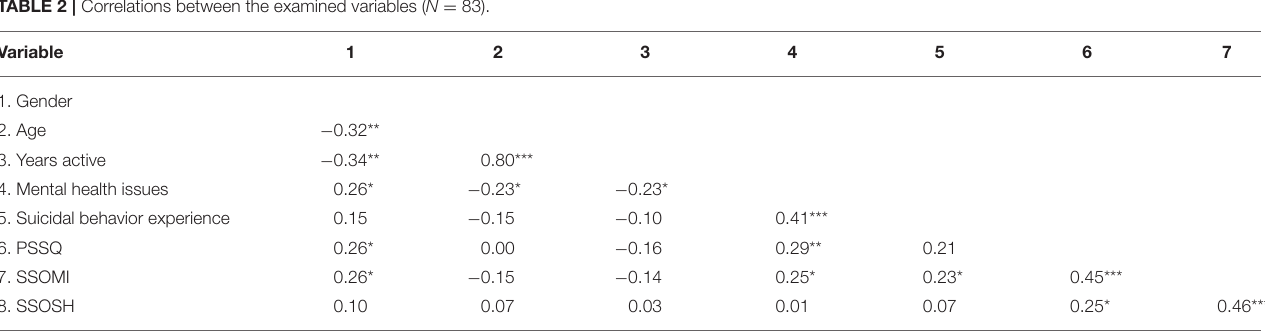
TABLE 2 | Correlations between the examined variables ( N =